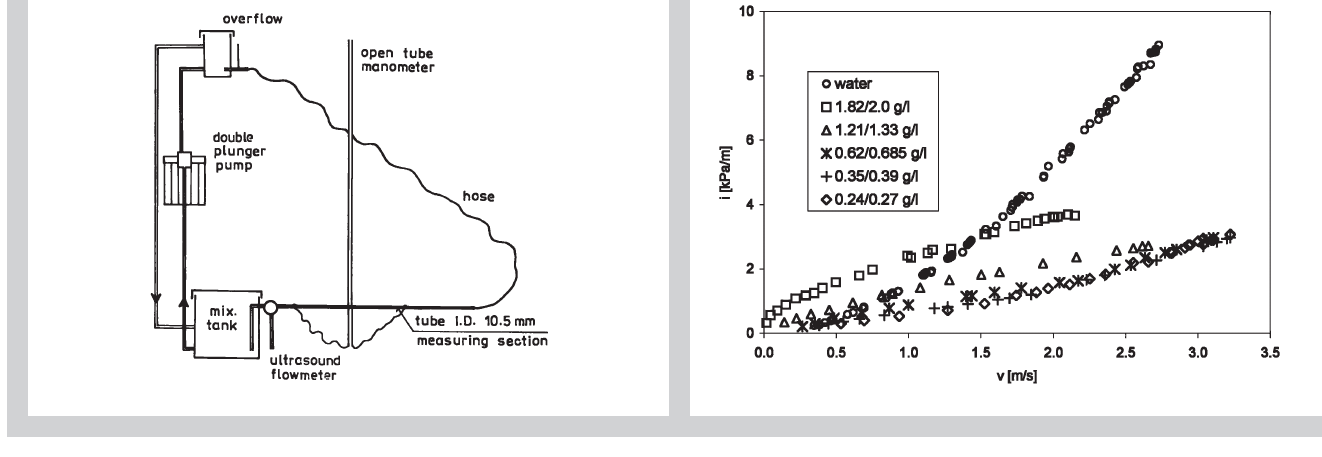
Figure 1 (left): Scheme of experimental facility. Figure 2 (right): Dependence of pressure drop, i, on mean velocity, v, in the 10.5 mm diameter tube at 20xxxC. Solutions of CTAB/NaSal 2 to 4 days old with shown concentrations which in g/l are